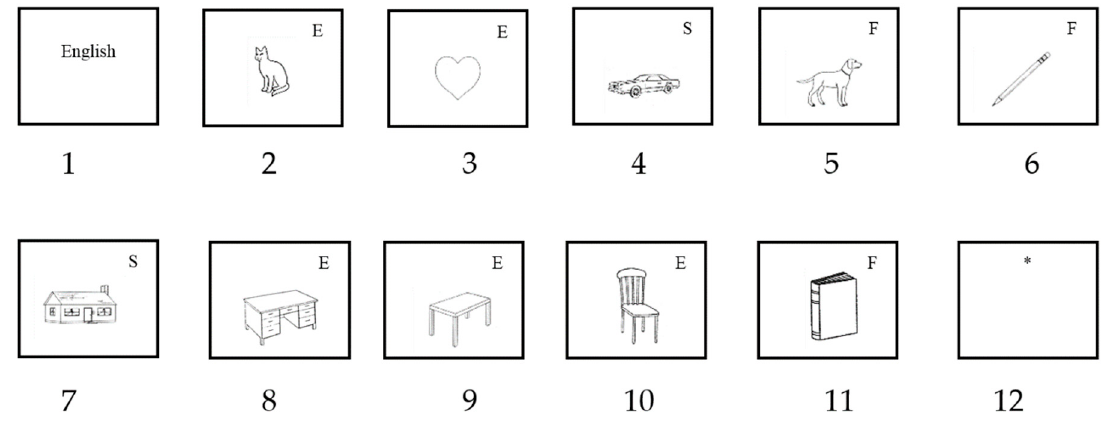
Figure 1. Example of picture naming task with language switches. Note: The letters E, F, and S represent whether the pictures were to be named in English (blue background), French (red background) or Spanish (yellow background), respectively. Pictures appeared for 2000 ms or a until response was recorded through the microphone, with an inter-stimulus interval of 800 ms.